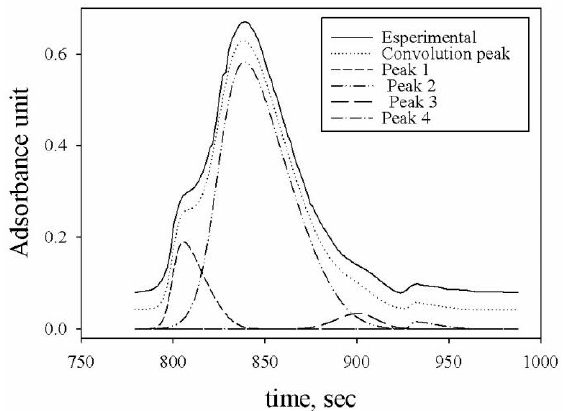
Figure 2. Size exclusion chromatography (SEC)-UV chromatogram: Molecular mass distribution of HA extracted from soil; peak numbers, obtained by the deconvolution program, represent the different dimensional classes of detected fractions, 52 KDa (peak 1), 4.5 KDa (peak 2), and 900 Da (peak 3), the peak 4 size cannot be attributed because of its dimension is lower than the inferior limit of the column (500 Da).